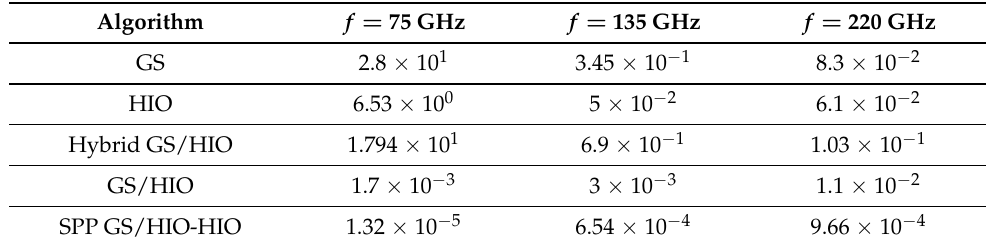
Table 1. Comparison of the NRMSE of the proposed SPP GS/HIO-HIO algorithm and the other four